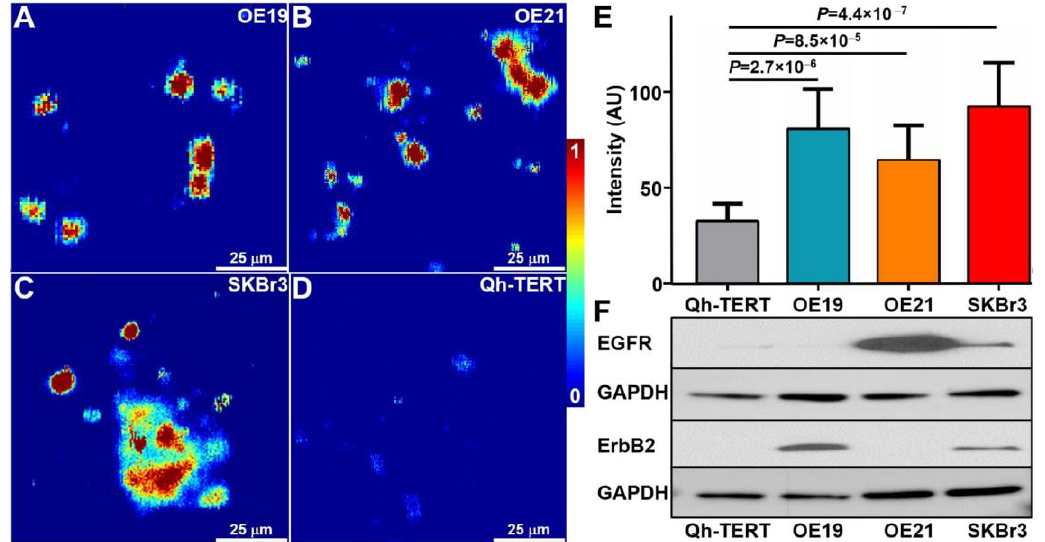
Figure 3. Photoacoustic microscopy. ( A – C ) In vitro images of human OE19 (ErbB2+), OE21 (EGFR+), and SKBr3 cells (EGFR+/ErbB2+) incubated with HB-Au-NPs at a concentration of 100 µ g/mL show strong signal. ( D ) Image of Qh-TERT cells (EGFR-/ErbB2-) used for control at same concentration shows minimal signal. ( E ) Quantified image intensities are shown. ( F ) Western blot supports EGFR and ErbB2 expression in each